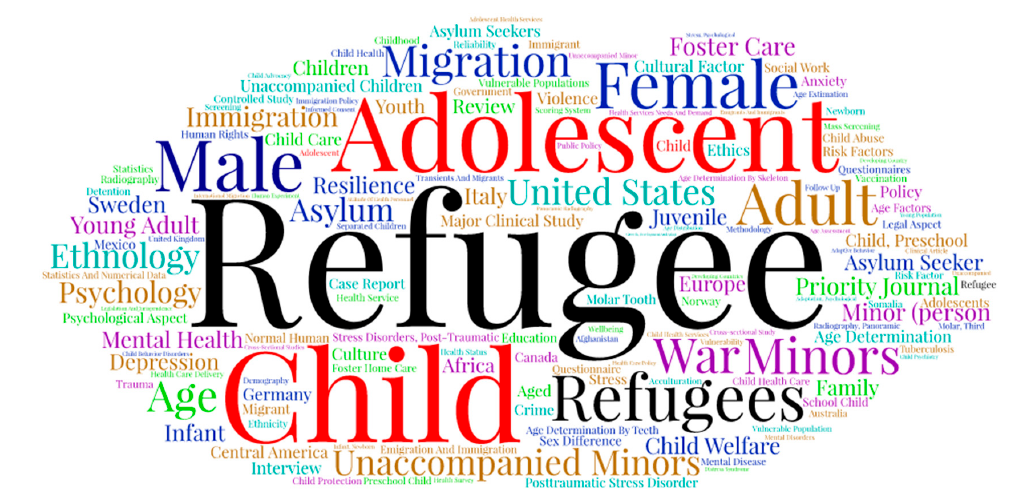
Figure 7. Cloud of words with keywords used in unaccompanied minors’ work.